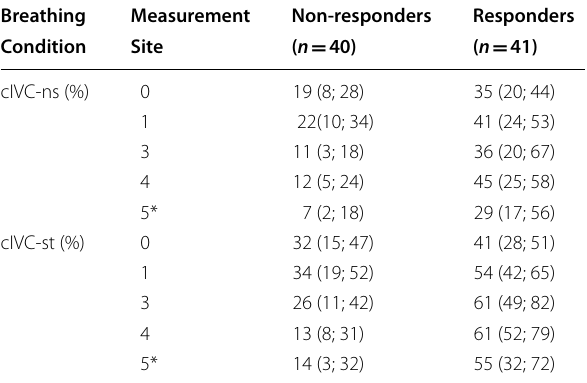
Table 2 Collapsibility index of the inferior vena cava (cIVC) in non-responders and responders before volume